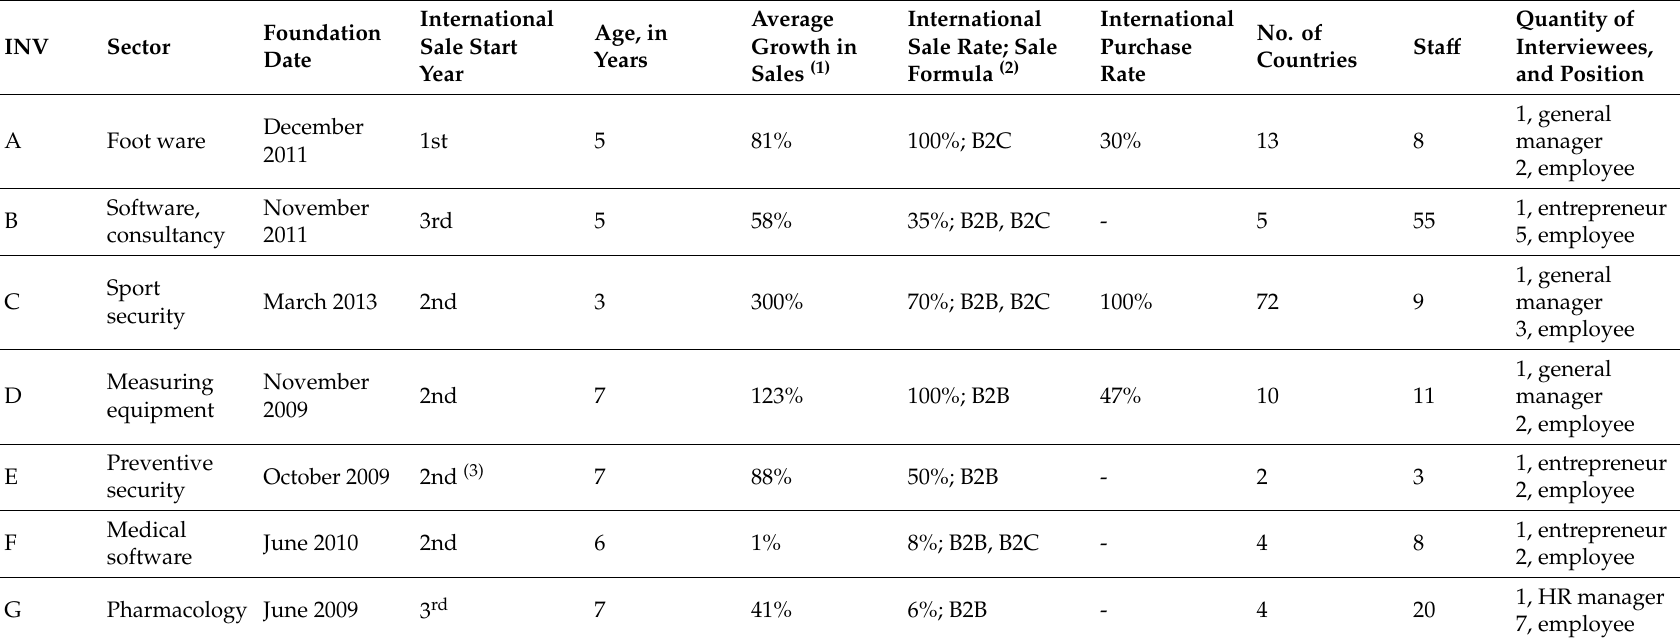
Table 2. INVs at the moment of the